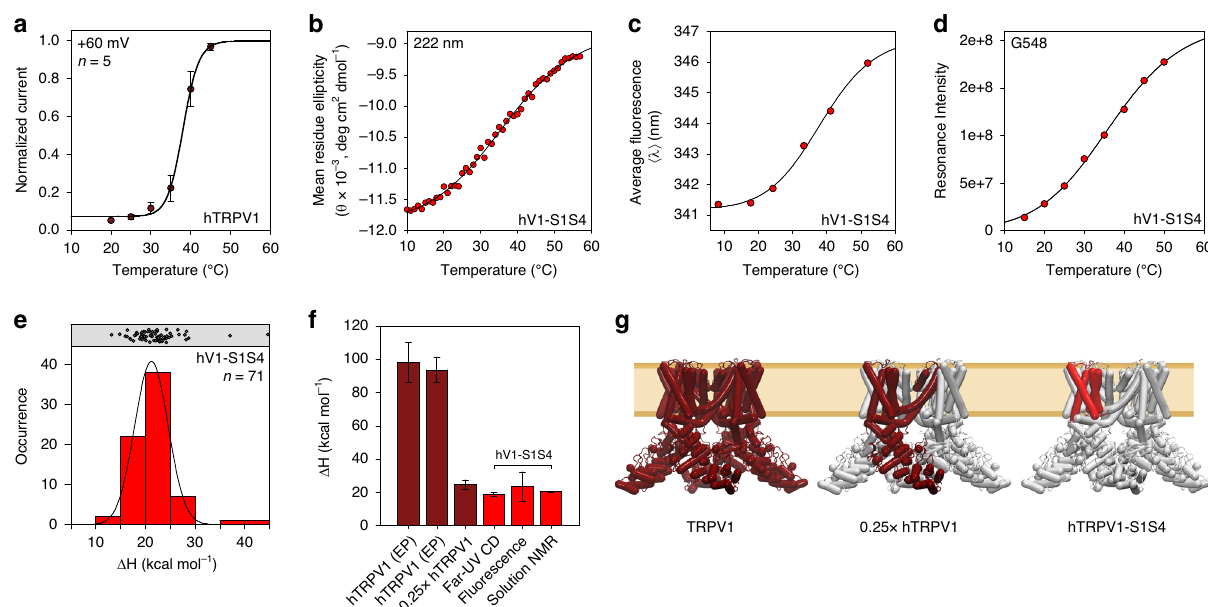
Fig. 2 Temperature-dependent two-state behavior and thermodynamic analysis of hTRPV1 and hV1-S1S4. a Whole-cell patch-clamp electrophysiology measurements from full-length human TRPV1 in HEK293 cells. b Temperature ramp of hV1-S1S4 monitored by far-UV circular dichroism shows two-state behavior. c The fi rst moment of intrinsic tryptophan fl uorescence of hV1-S1S4 as a function of temperature shows two-state transition similar to that identi fi ed by CD. d Representative NMR resonance (peak) intensity, G548 in the S4 helix, shows two-state behavior. G548 was chosen due to its similarity to the mean Δ H obtained from NMR. e A histogram of 71 enthalpies from NMR resonance (peak) intensities are shown in red with individual data points shown above as black circles. These data fi t to a Gaussian function (black line) provide an average value of 21.2 ± 0.1 kcal mol − 1 . f Comparison of Δ H values, the fi rst two dark red bars are from the cellular electrophysiology measurements for full-length hTRPV1 from steady-state currents ( a ) and temperature ramps. A calculated value for one quarter of the steady-state value is also shown. The Δ H values from CD, fl uorescence, and NMR are shown in red. g The left panel shows the full-length TRPV1 used for electrophysiology measurements. The middle panel shows the relative size of a TRPV1 monomer. The right panel shows the hV1-S1S4 domain in red, which has similar Δ H as the monomer, showing the relative signi fi cance of the hV1-S1S4 in thermosensitivity. The mid-point of the temperature dependence, T 50 , for the resulting electrophysiology ( a ), CD ( b ), fl uorescence ( c ), and NMR ( d , e ) are 38.1 ± 0.3, 36 ± 1, 38 ± 2, and 40.7 ± 0.6 °C respectively. Errors represent s.e.m. and source data are provided as a Source Data fi fi t to a two-state model representing closed (resting) and open (active) states resulting in a measured Δ H of 98 ± 12 kcal mol − 1 (Fig. 2a), with a T 50 of 38.1 ± 0.3 °C. Independently, we used a second method involving temperature ramps from 20 to 50 °C and fi t the data to a pseudo-steady-state thermodynamic model to obtain hTRPV1 Δ H values (see Methods), resulting in an average Δ H of 94 ± 8 kcal mol − 1 (Supplementary Fig. 5). The Δ H values of human TRPV1 measured from the steady-state current and the temperature ramp methods are consistent with those of rodent TRPV1 from previous studies, which is ~90 kcal mol − 1 (Supple- mentary Table 1).